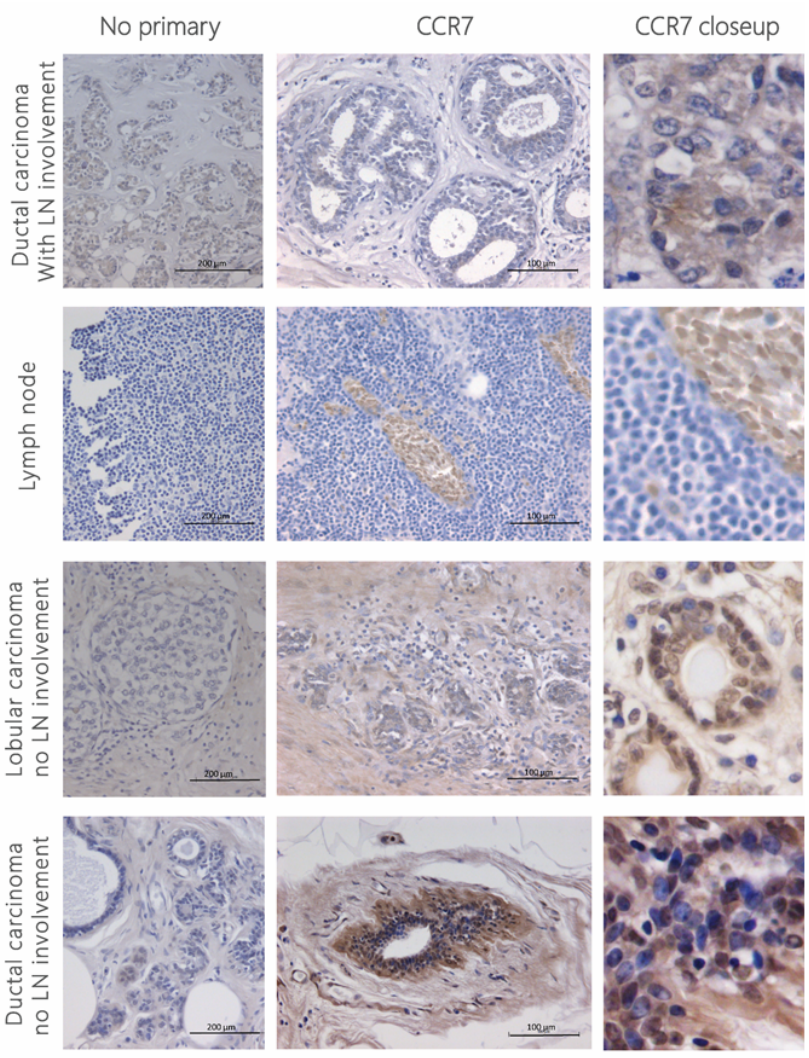
Figure 1. CCR7 staining in human breast cancer tissue. Four-micrometre sections from human invasive breast cancer were stained for anti-human CCR7 (1:50) using the ImmPRESS polymer